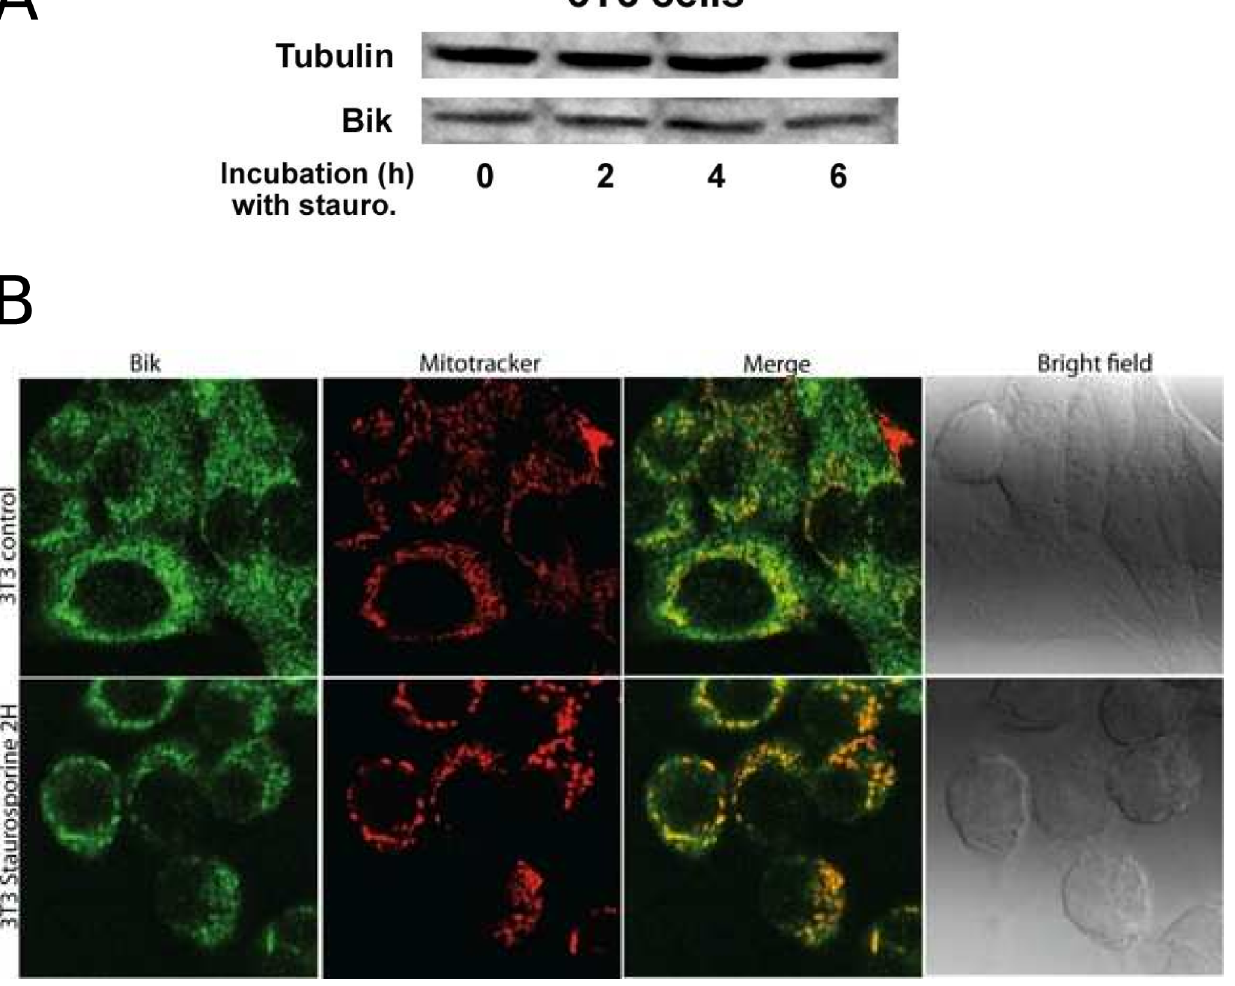
Figure 4. Bik behavior after a death stimulus. A Bik immunoblotting in presence of staurosporine in parental NIH-3T3 cells. Bik protein amount remained constant during apoptosis. B Bik relocalized from ER to mitochondria during staurosporine exposure in parental NIH-3T3 cells. Mitochondria were labeled by Mitotracker (red). Endogenous Bik was tracked by an anti-Bik-BH3 and a secondary antibody labeled with FITC (green). Yellow indicated